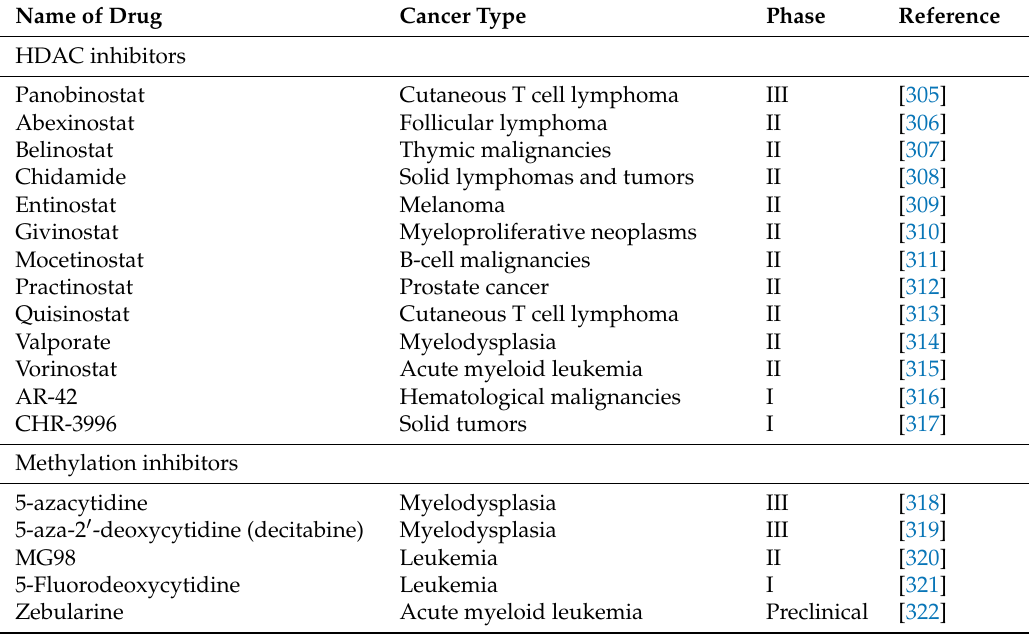
Table 7. Some drugs against HDAC and DNA methylation that are in clinical